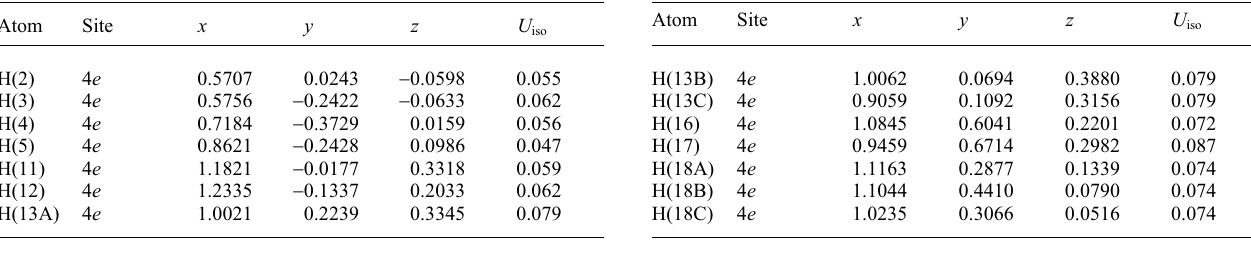
Table 3. Atomic coordinates and displacement parameters (in Å 2 ).